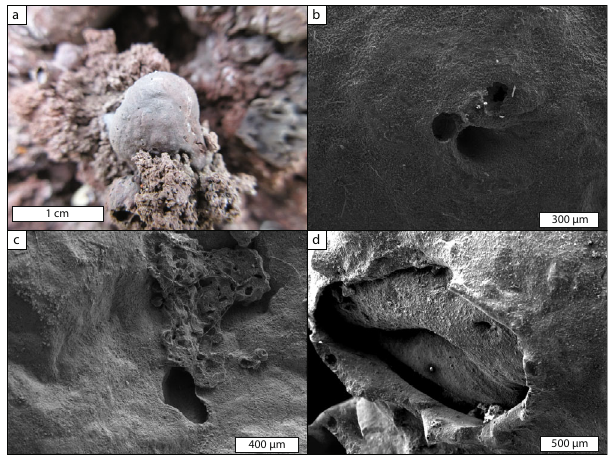
Fig. 3 In fl ated pyroclast textures and detailed features. a Close up photograph of an in fl ated pyroclast within the scoria cone deposit. The clast surface contains a few small ( ≲ 0.5 mm) holes. b – d Scanning electron micrographs of in fl ated pyroclast surfaces showing: b circular non-brittle holes on the pyroclasts surface; c smaller pieces of vesicular scoria stuck to the in fl ated pyroclast and d multiple layers or skins. Further photographs of individual pyroclasts can be found in Fig.